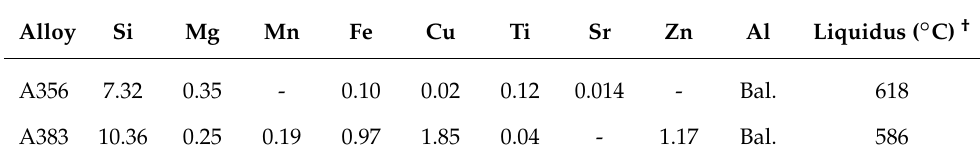
Figure 2. The experimental procedure of the present suction fluidity test. Table 1. Alloy compositions (wt%) of the A356 and A383 aluminum alloys employed in the present